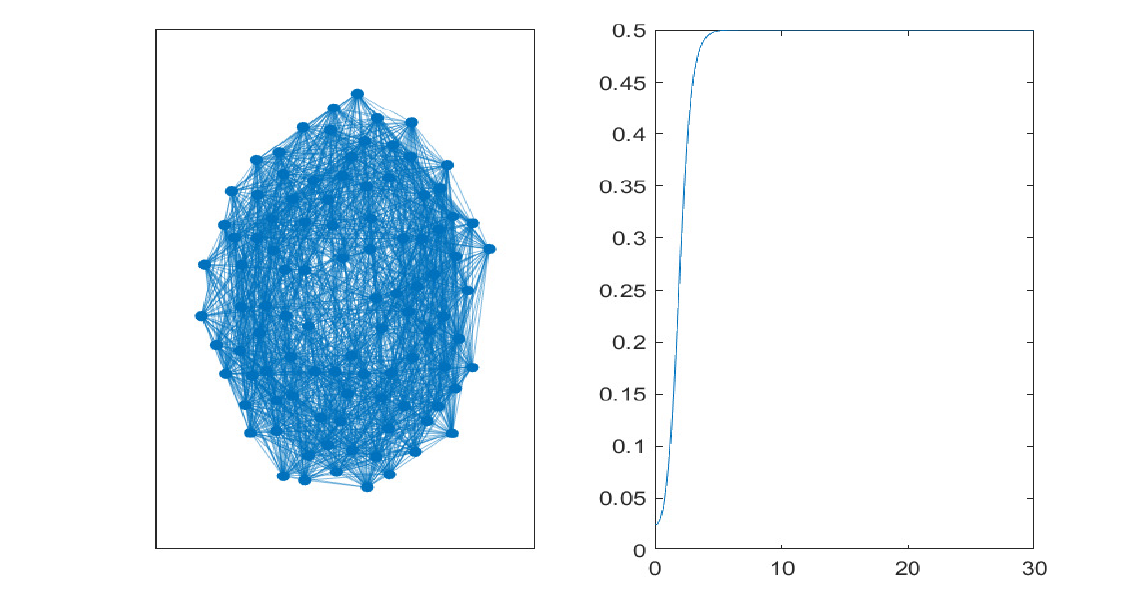
Figure 12. Small-world (Watts–Strogatz) network with 100 nodes and a rewiring probability of β = 0.2 ( left ). Time evolution of the mean value of non-performing loans on the graph ( right